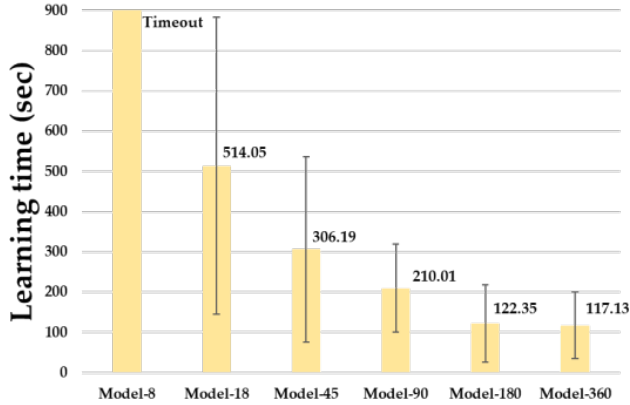
Figure 11. Learning Time of Prediction Models.